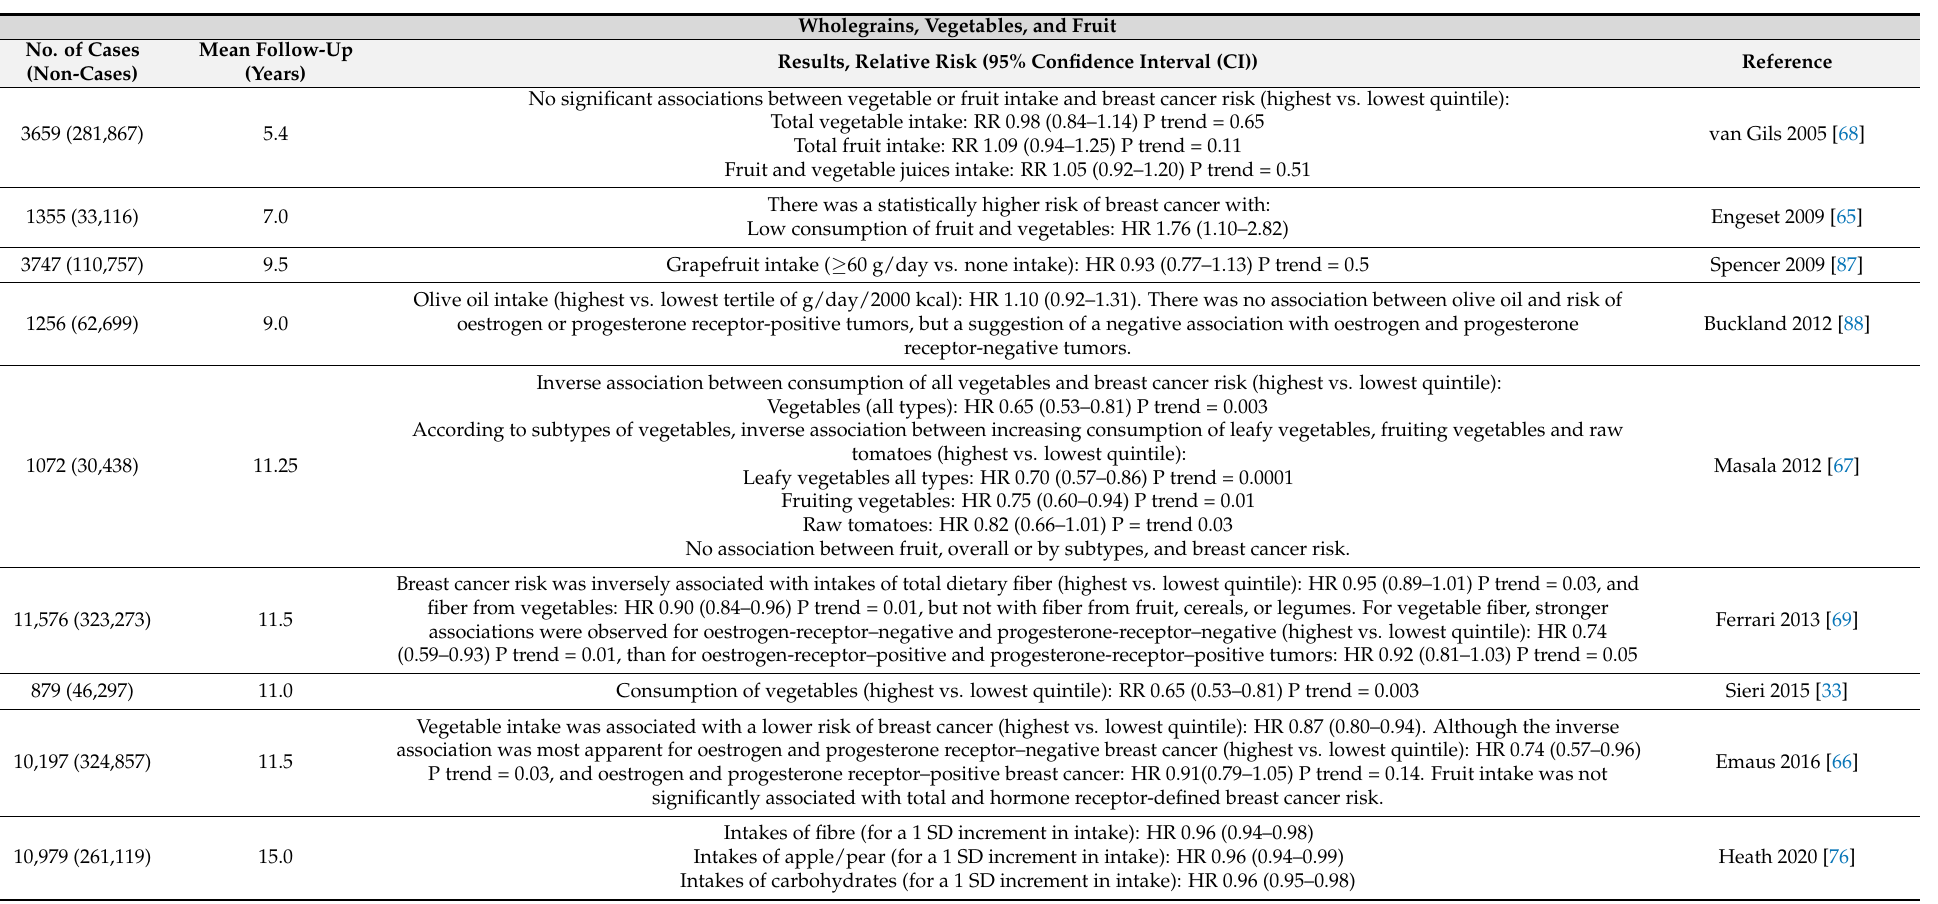
Table 2. Evidence synthesis of the association between diet and breast cancer in the EPIC study. Wholegrains, Vegetables, and Fruit No. of Cases No significant associations between vegetable or fruit intake and breast cancer risk (highest vs. lowest quintile): Total vegetable intake: RR 0.98 (0.84–1.14) P trend = 0.65